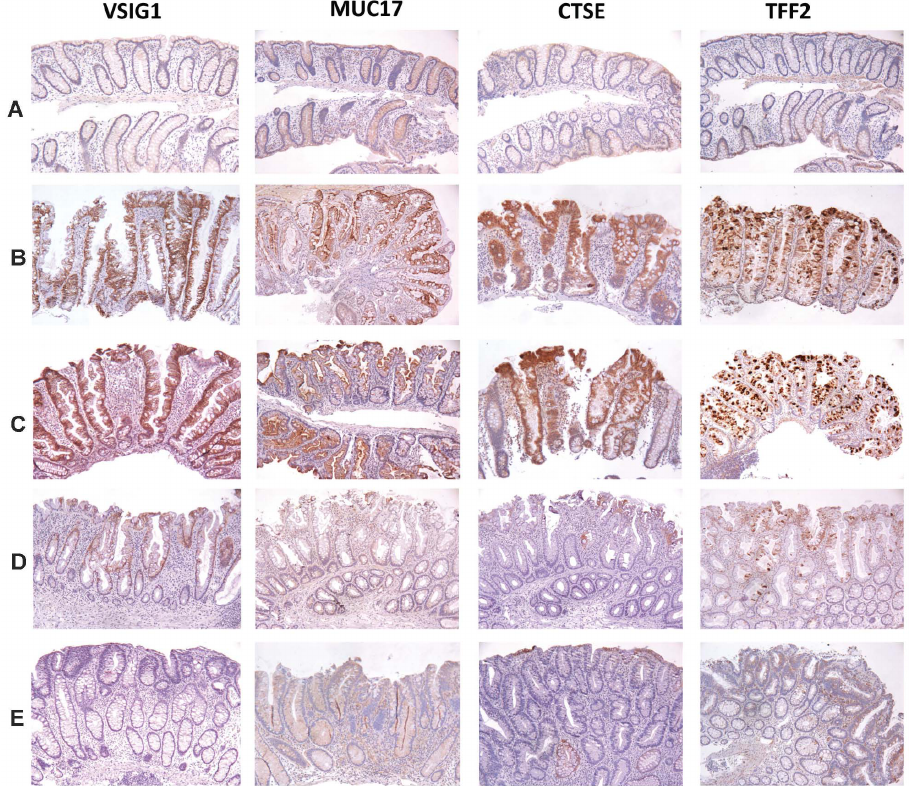
Figure 4. Immunostaining for VSIG1, MUC17, CTSE and TFF2 in control colon, SSA/Ps, hyperplastic and adenomatous polyps. Representative images of immunoperoxidase staining with affinity purified polyclonal antibodies and formalin-fixed, paraffin-embedded biopsies of patient matched and normal control colon (Panel A, n=15, see Methods), syndromic SSA/Ps (Panel B, n=10), sporadic SSA/Ps (Panel C, n=15), hyperplastic polyps (Panel D, n=10) and adenomatous polyps (Panel E, n=10) are shown. Representative immunohistochemical stains for REG4 in control and polyp specimens are provided in Figure S2 in File S1.